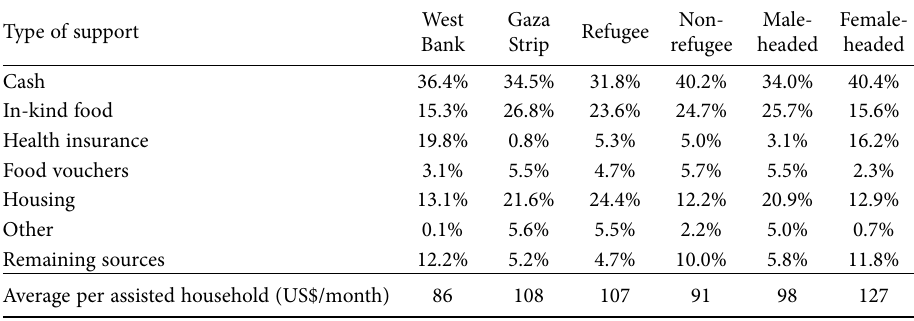
Source: FSS-PCBS (2016): Table 7.4,